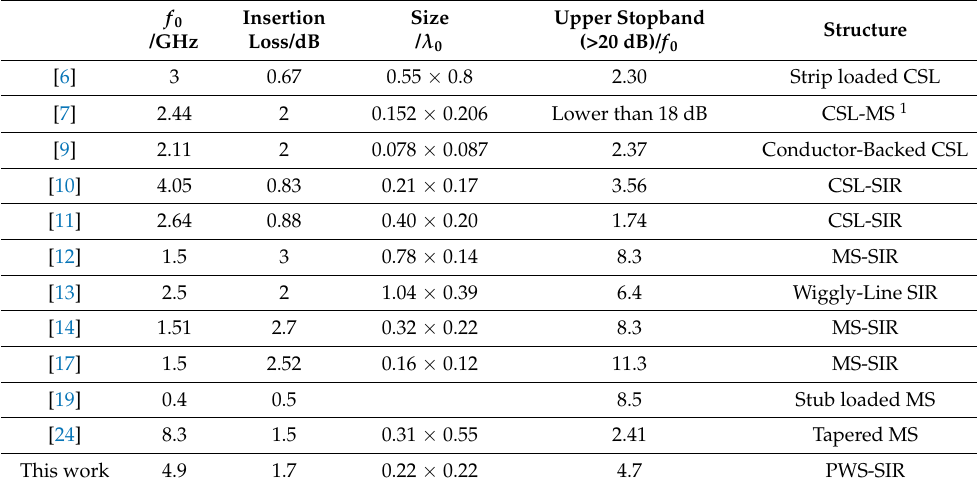
Table 2. Comparison Of The Slotline Filters With